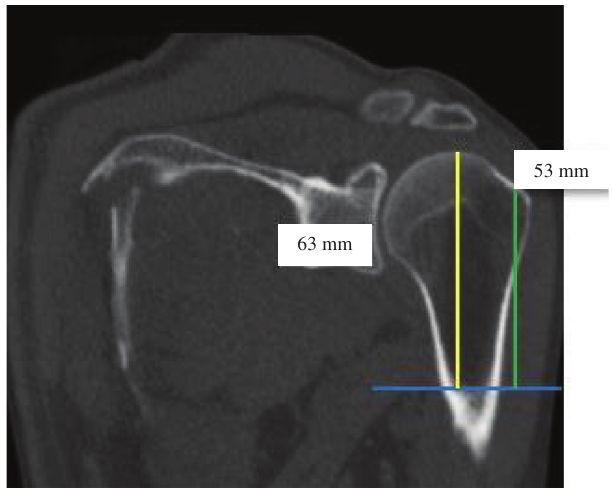
Figure 12. PM-humeral head distance (yellow) was almost equal to PM-greater tubercle distance (green) (ratio = 0.9).